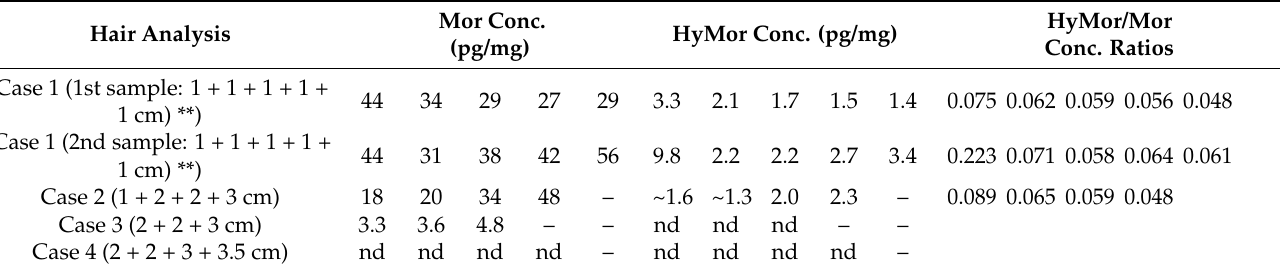
Table 2. Results of hair segment testing in morphine intoxication cases *).